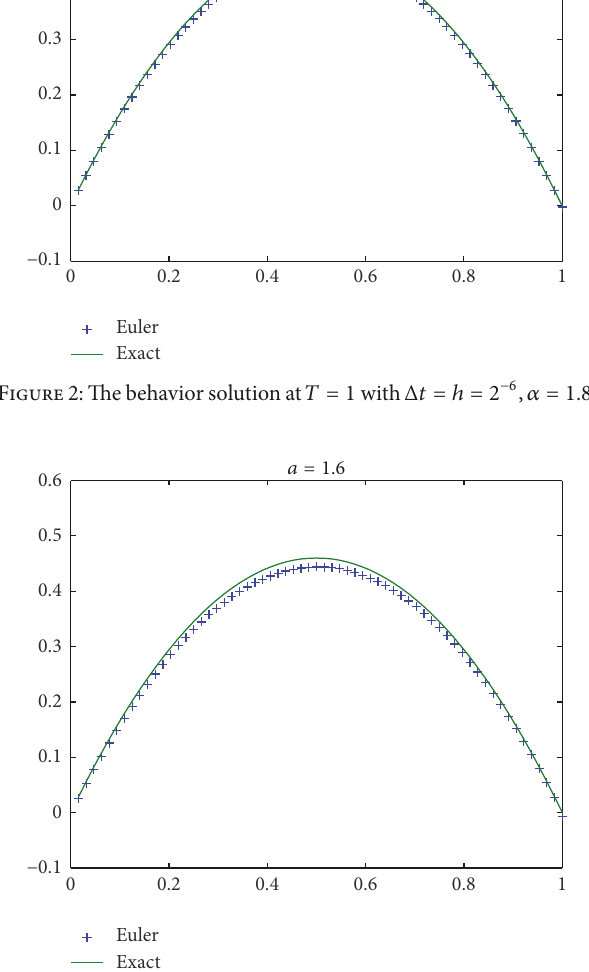
Figure 3: The behavior solution at 𝑇 = 1 with Δ𝑡 = ℎ = 2 −6 , 𝛼 = 1.6 .